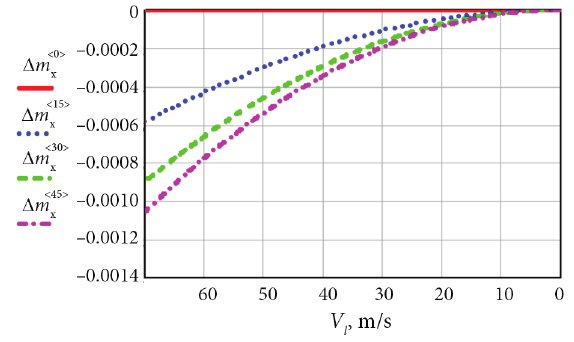
Figure 3. Normal force increase on main landing gear right-side tires